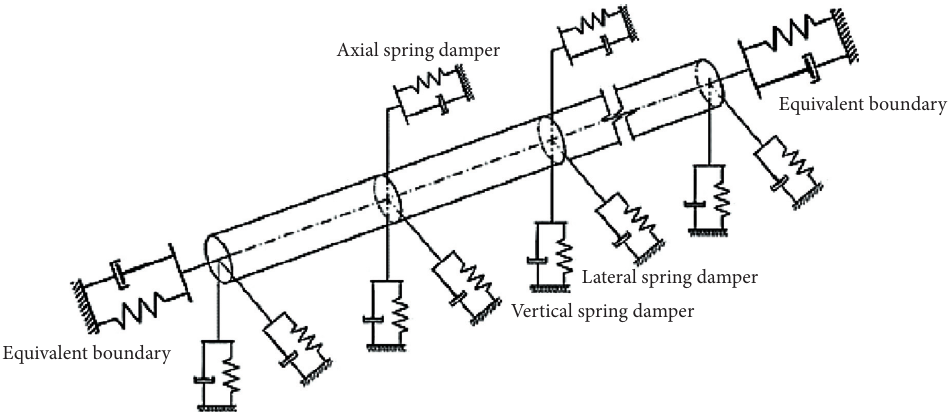
Figure 15: Apparent propagation of an R wave, strain of the ground, and curvature